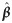
Native forest coefficients in the logit scale (β^ ±SD, 95% BCI) on logit occupancy (logit ψ^) of each bird species in the regional bird monitoring program in Argentina, 2003–2012.(a) Raptors; (b) ground omnivores and herbivores; (c) ground granivores; (d) other granivores; (e) insectivores mostly associated with folliage; (f) other insectivores. For details of species names and guilds, see S1 Table.